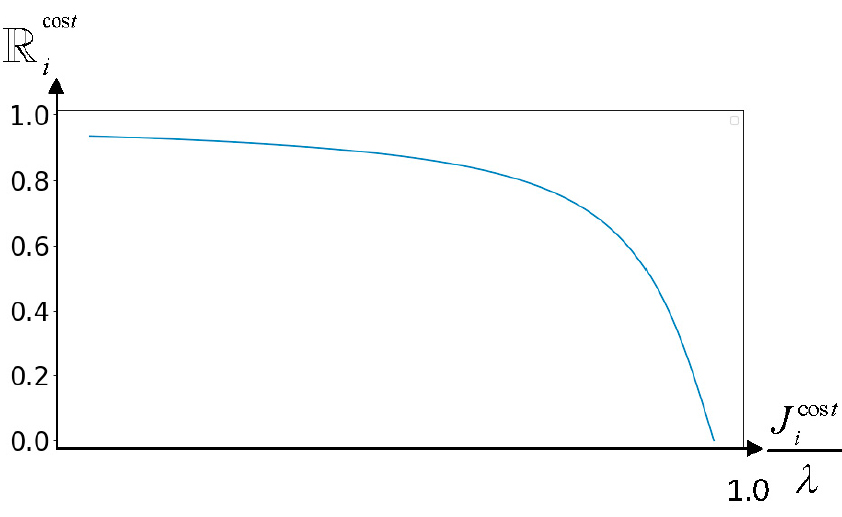
Figure 4. Nonlinear decrease of the reward function R cost with J cost .